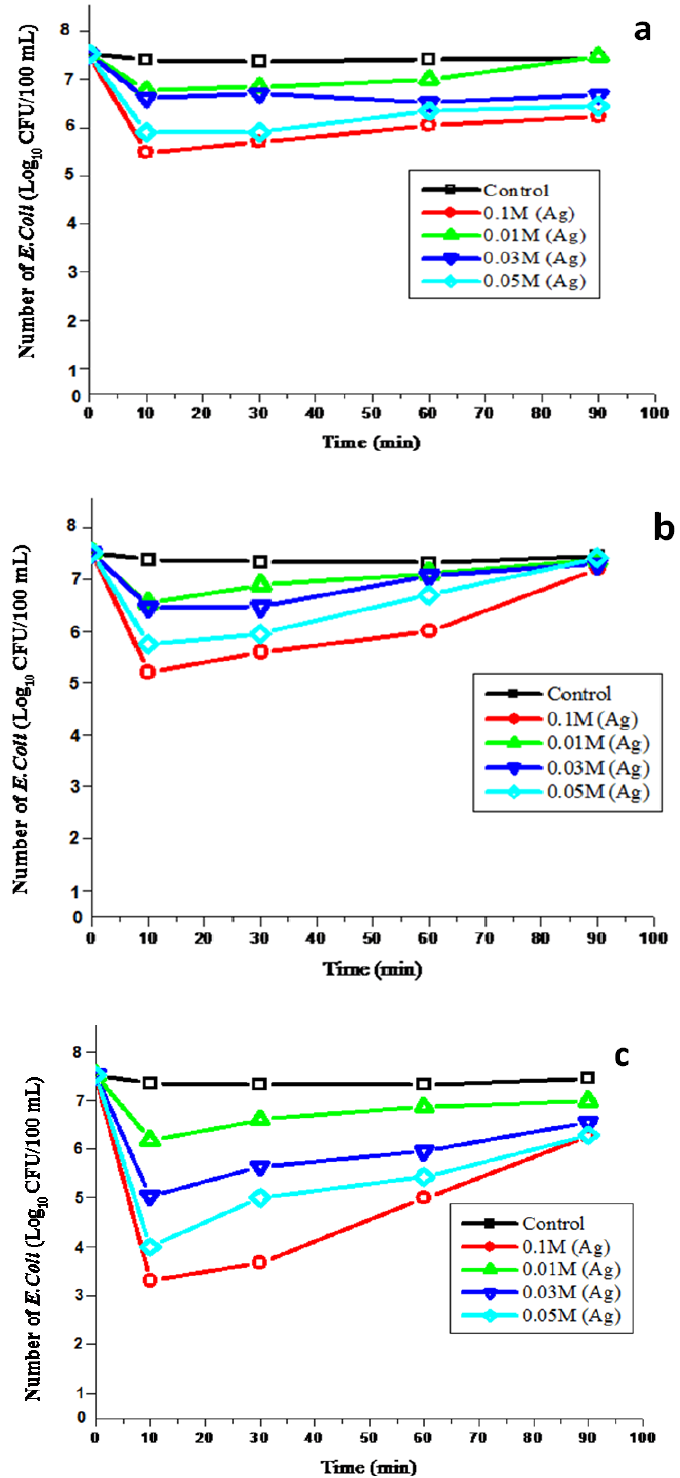
Figure 5. Antibacterial activity of various Ag nanoparticle-coated substrates against E . coli at different concentrations in synthetic water: ( a ) zeolite, ( b ) sand, ( c ) fibreglass, ( d ) anion resin, and ( e ) cation